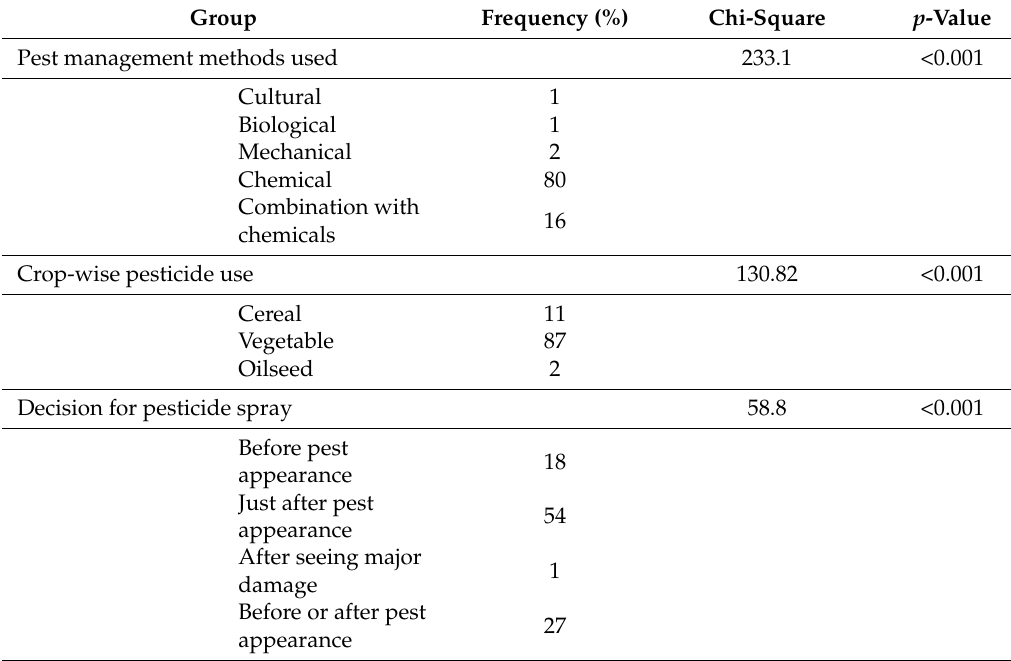
Table 2. Current pest management practices among vegetable growers in Chitwan, Nepal.